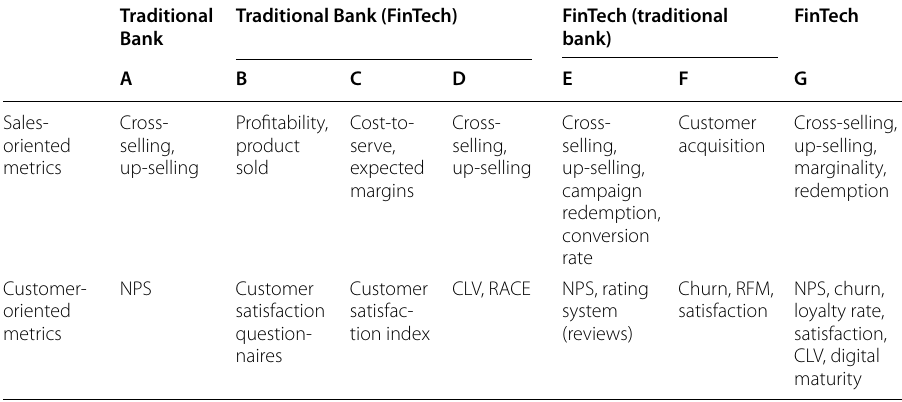
Table 2 Details on sales-oriented and customer-oriented metrics (Performance